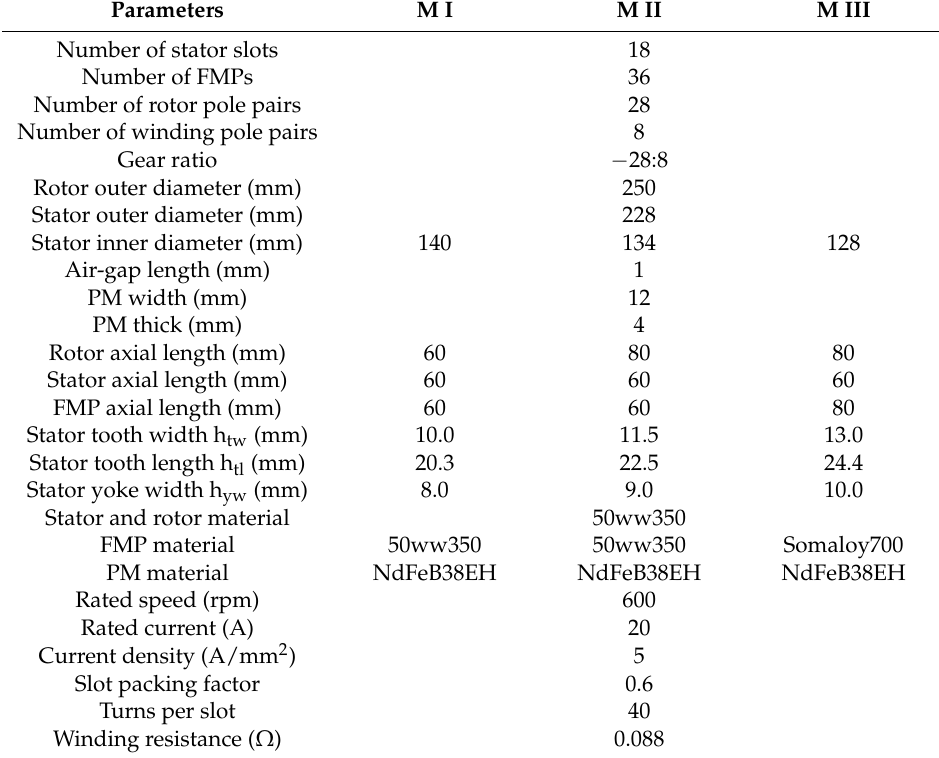
Figure 1. The configurations of the three machines. ( a ) M I: conventional PMVM. ( b ) M II: PMVM with rotor overhang. ( c ) M III: proposed PMVM with rotor and FMP overhang. ( d ) Cross-section of conventional stator tooth. ( e ) Side view of the proposed stator tooth. ( f ) FMP prototype. ( g ) Winding configuration. Table 1. Main specifications of the three machines.